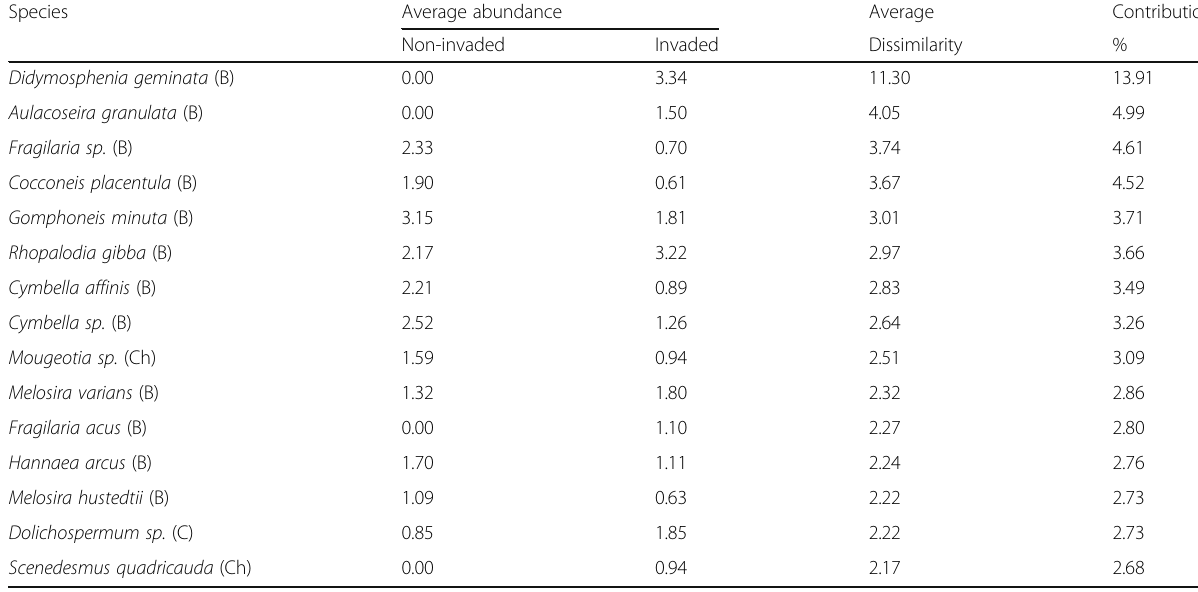
Table 3 Similarity percentage analysis (SIMPER). Average abundance values are shown for phytobenthos species at sites non-invaded (LIU) and invaded (MAR, TAL, and LOL) by D. geminata . The comparison between both sites is shown, along with average dissimilarity values and contribution percentages (%). Bacillariophyceae (B), Cyanophyta (C), Chlorophyta (Ch)